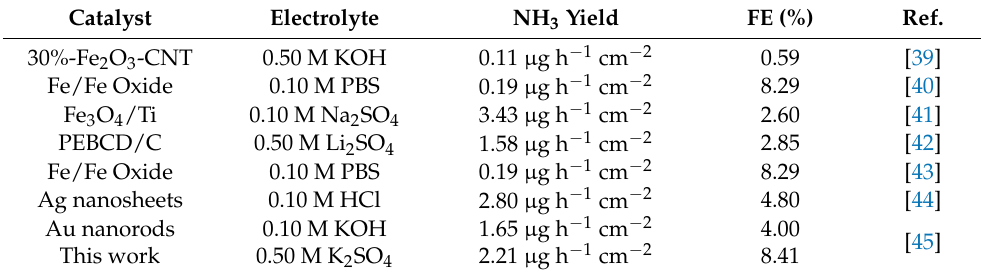
Figure 3. ( a ) NRR electrochemical performances of CeO 2 -ZIF-8 in 0.5 M K 2 SO 4 at a scan rate of 2 mV/s; ( b ) Faradaic efficiency (red) and yield rate of NH 3 (blue) at each potential; ( c ) cycling test of the CeO 2 -ZIF-8 at − 0.5 V vs. RHE for 2 h of each NRR experiment in N 2 -saturated 0.5 M K 2 SO 4 solution (pH 3.5); ( d ) time-dependent current density during electrolysis at − 0.5 V vs. RHE for 30,000 s. Table 1. Comparison of the electrocatalytic N 2 reduction performance for CeO 2 -ZIF-8/CPs with other aqueous-based NRR